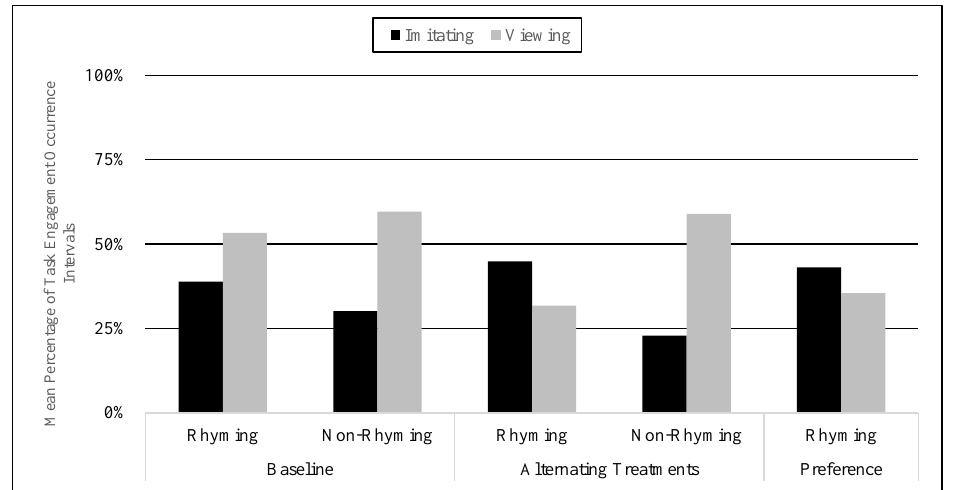
Figure 2. Engagement: Mean Percentage of Task Engagement Occurrence Intervals in Viewing and Imitating Behaviors.